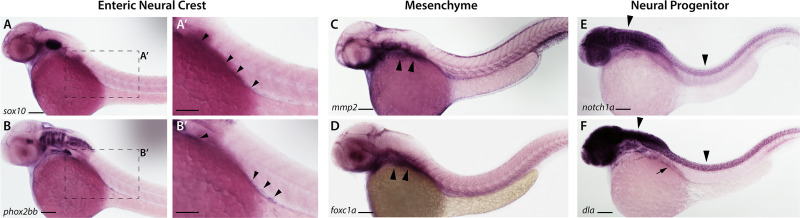
Whole mount in situ hybridization of select ENCC, mesenchyme and neural markers at 48–50 hpf.(A,A’) The marker sox10 is shown along the vagal region and within ENCC along the foregut in (A’; highlighted via arrowheads). Scale bar in (A): 60 μM, in (A’): 40 μM. (B, B’) Expression of phox2bb is shown within the hindbrain-axial level of the embryo, as well as within ENCC within the foregut (B’; highlighted via arrowheads). Scale bar in (A): 60 μM, in (A’): 40 μM. (C,D) The mesenchyme markers mmp2 (C; highlighted via arrowheads) and foxc1a (D; highlighted via arrowheads) are expressed within the posterior pharyngeal arches and the ventral mesenchyme. (E,F) The neural markers notch1a (E) and dla (F) are expressed within the hindbrain and spinal cord (arrowheads). (F) dla expression is seen in the ENCC (arrow). Scale bar in (C–F): 60 μM.